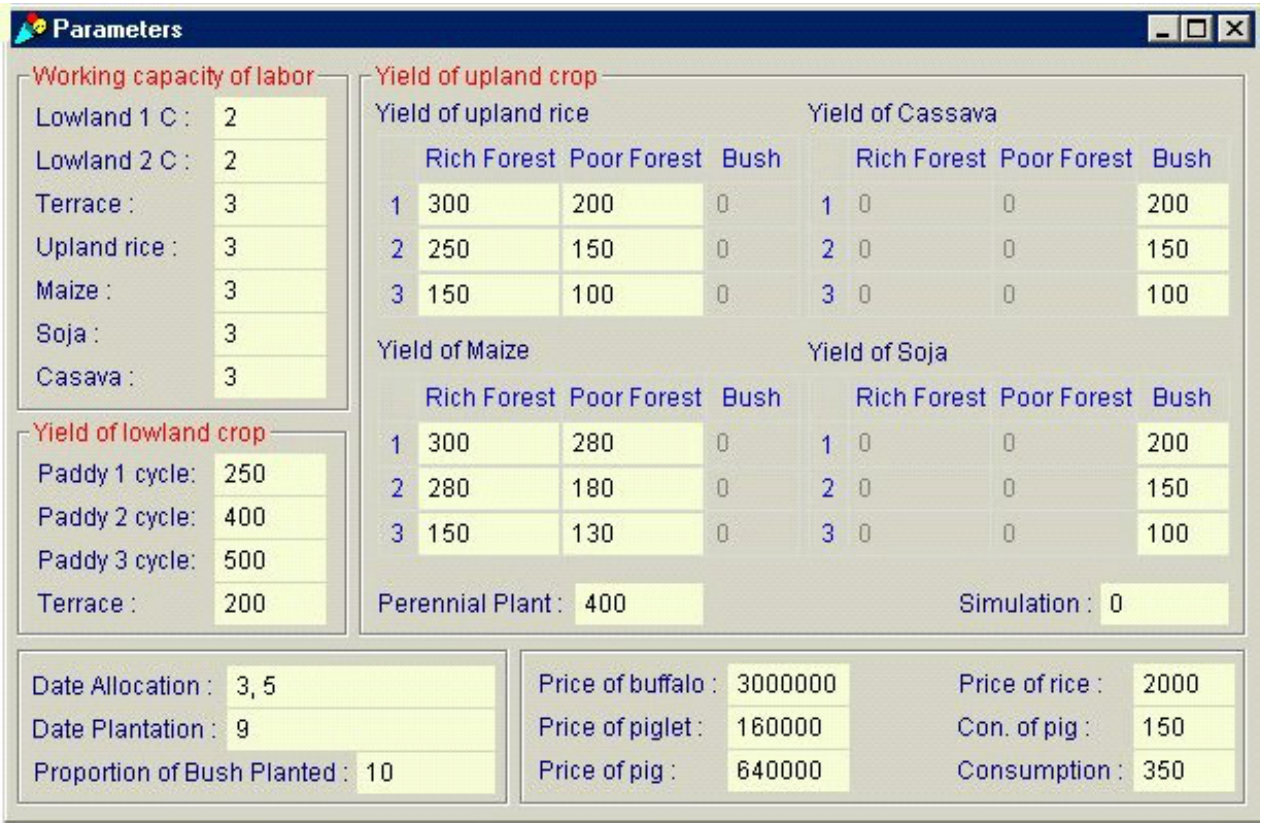
Fig. 3. Parameter interface of the SAMBA-GIS model. Units: labor capacity of worker (x 1000 m 2 /worker), yield of crop (kg/1000 m 2 ), prices in Vietnamese dong or VND (U.S. $1.00 = 19,000 VND in 2004), consumption (kg of equivalent